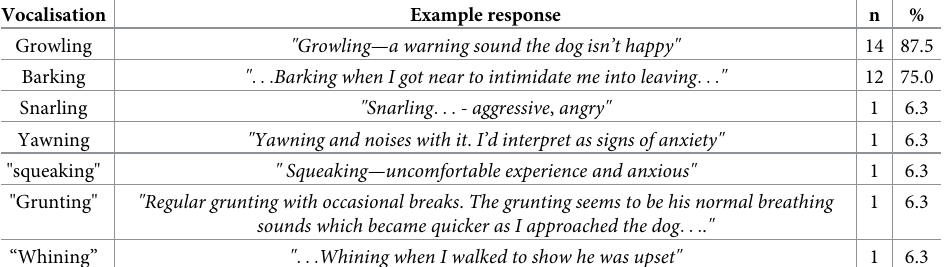
Table 3. Vocalisations reported by participants in an open-ended question post aggression scenario (multiple responses per person).